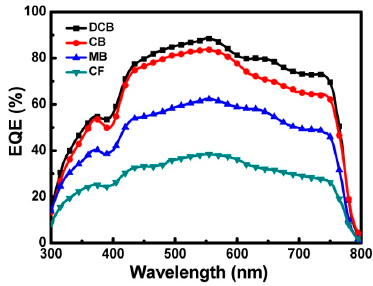
Figure 12. External quantum efficiency (EQE) spectra of the PSCs based on various ETL solvents.